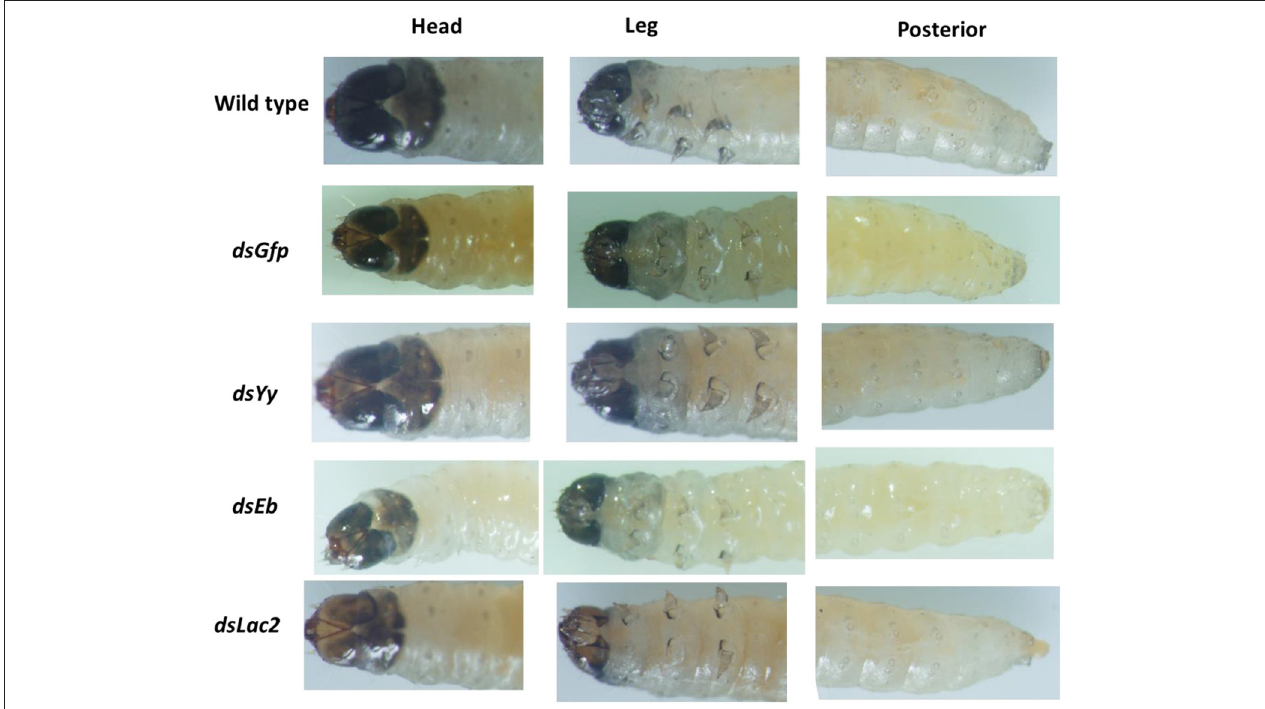
FIGURE 8 | Phenotypes resulting from the Lac2 feeding RNAi. Lac2 RNAi affected the pigmentation of the larval head. The larvae were fed 5 ug/ml 750-bp dsRNA of Gfp, Yellow-y ( Yy ), laccase-2 ( Lac2 ), and ebony ( Eb ) gene separately.